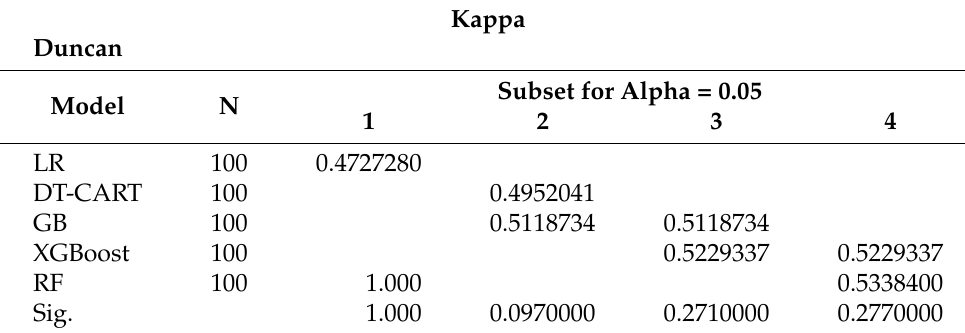
Table 7. Duncan’s test on Cohe’s Kappa metric.